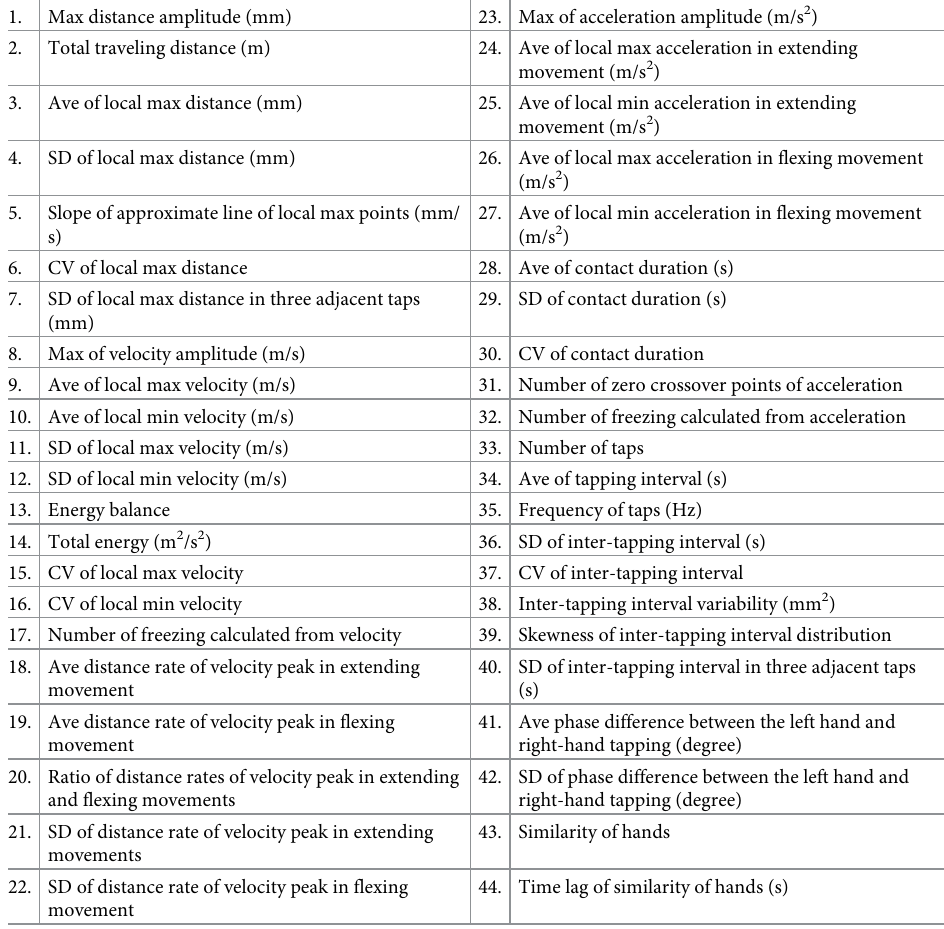
Table 1. Parameters of finger-tapping